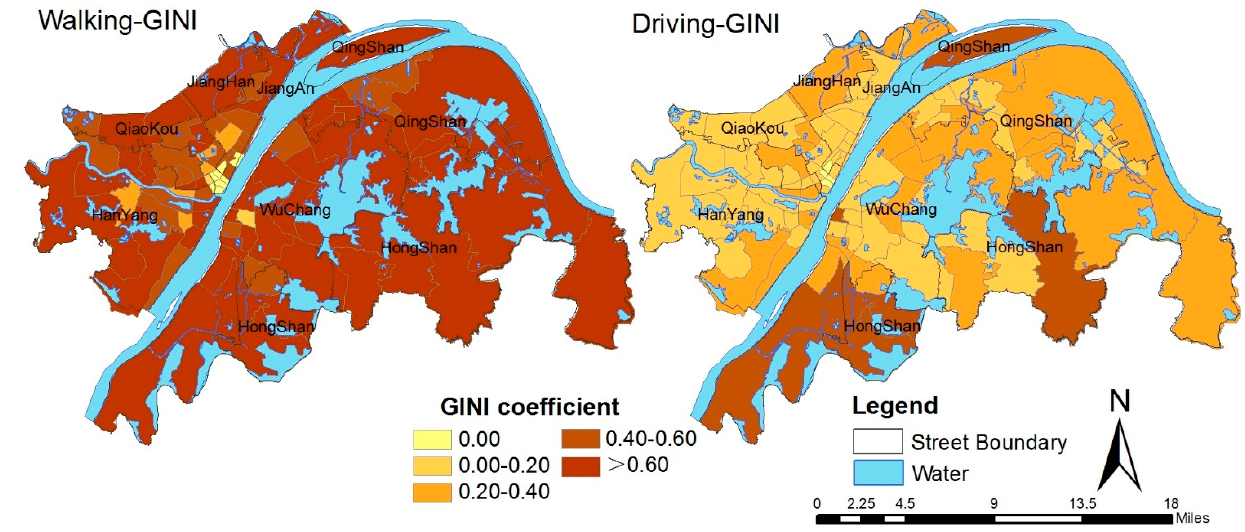
Figure 3. The Gini coefficients of accessibility and population by walking and driving.